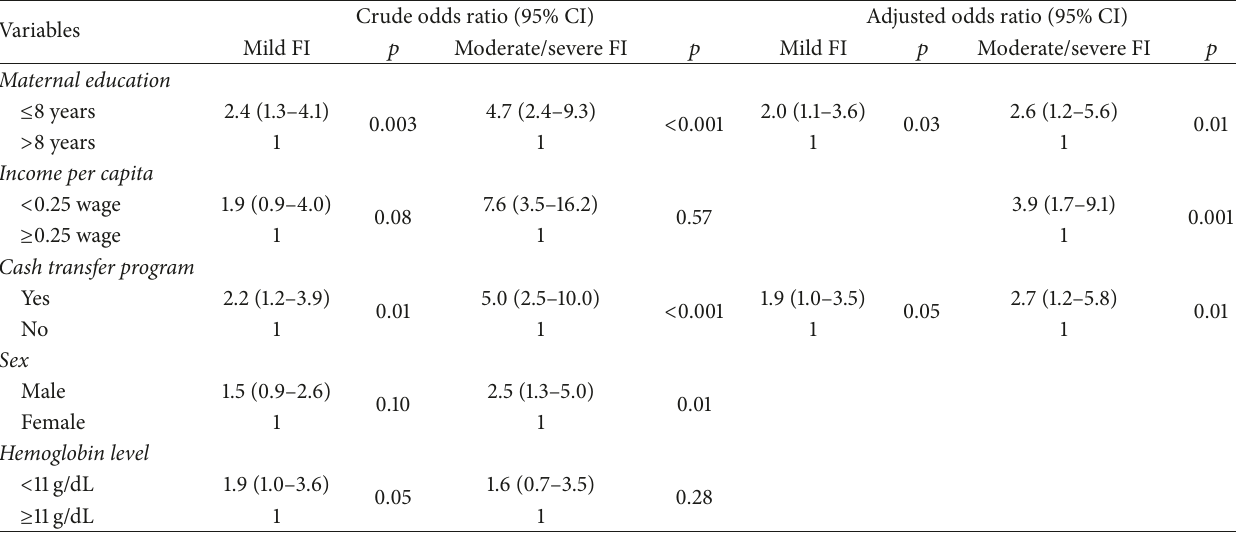
Table 3: Multivariate regression analysis of socioeconomics variables, child characteristics, and hemoglobin level and household food insecurity status. Taubat´e, S˜ao Paulo, Brazil,